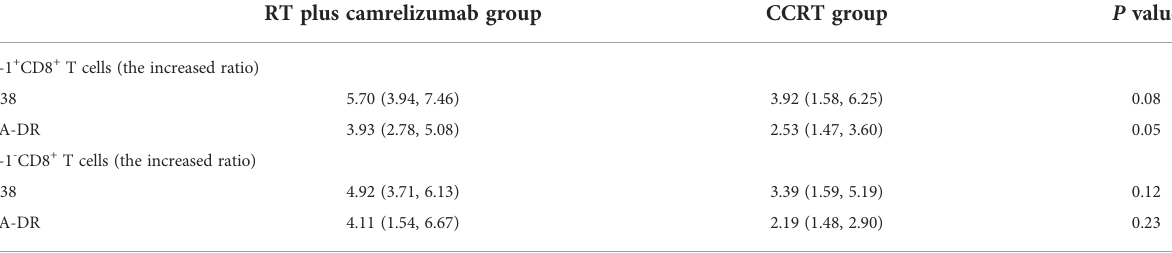
TABLE 3 The increased ratio (during/before treatment) of CD38 and HLA-DR expression levels on PD-1 + and PD-1 - CD8 + T cells. RT plus camrelizumab